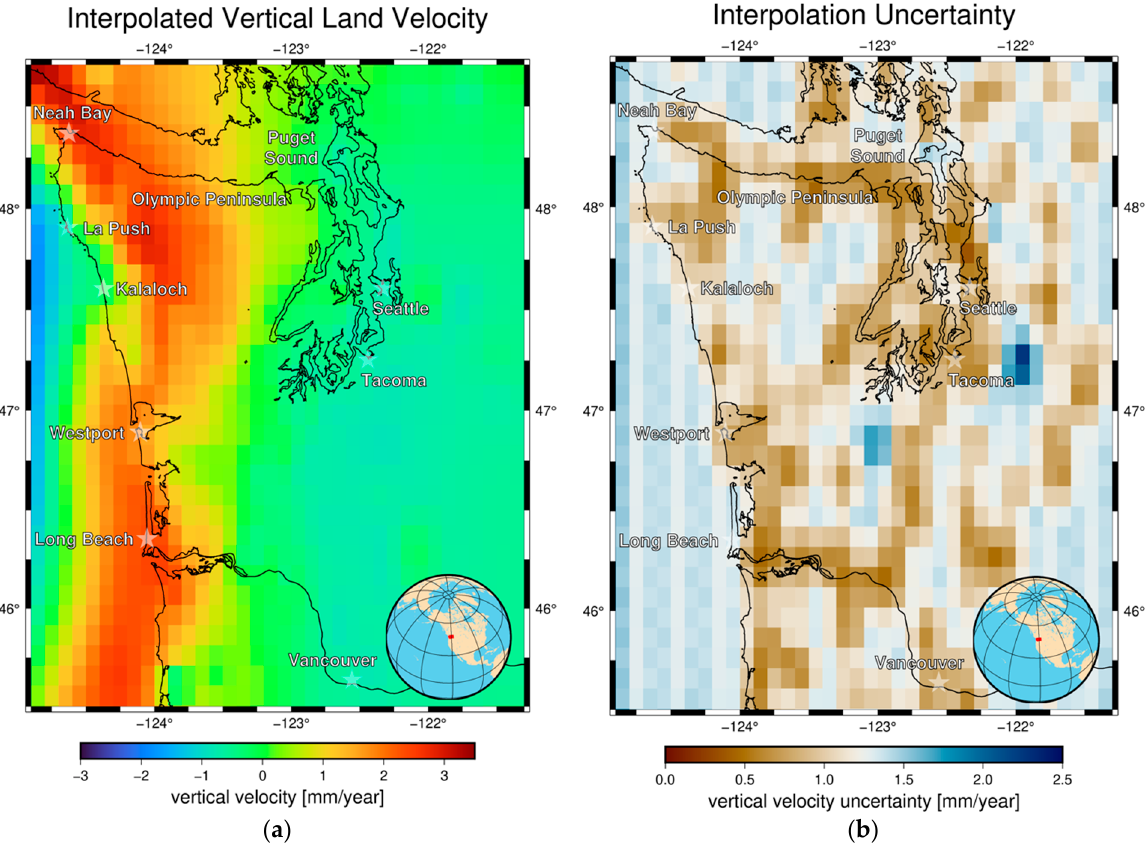
Figure 5. ( a ) Interpolated surface queried on a 0.1 degree grid representing a continuous vertical velocity field for coastal Washington (Data S3); ( b ) Bootstrapped uncertainty of the interpolated vertical velocity field shown in Figure 5a (Data S4). North is up.